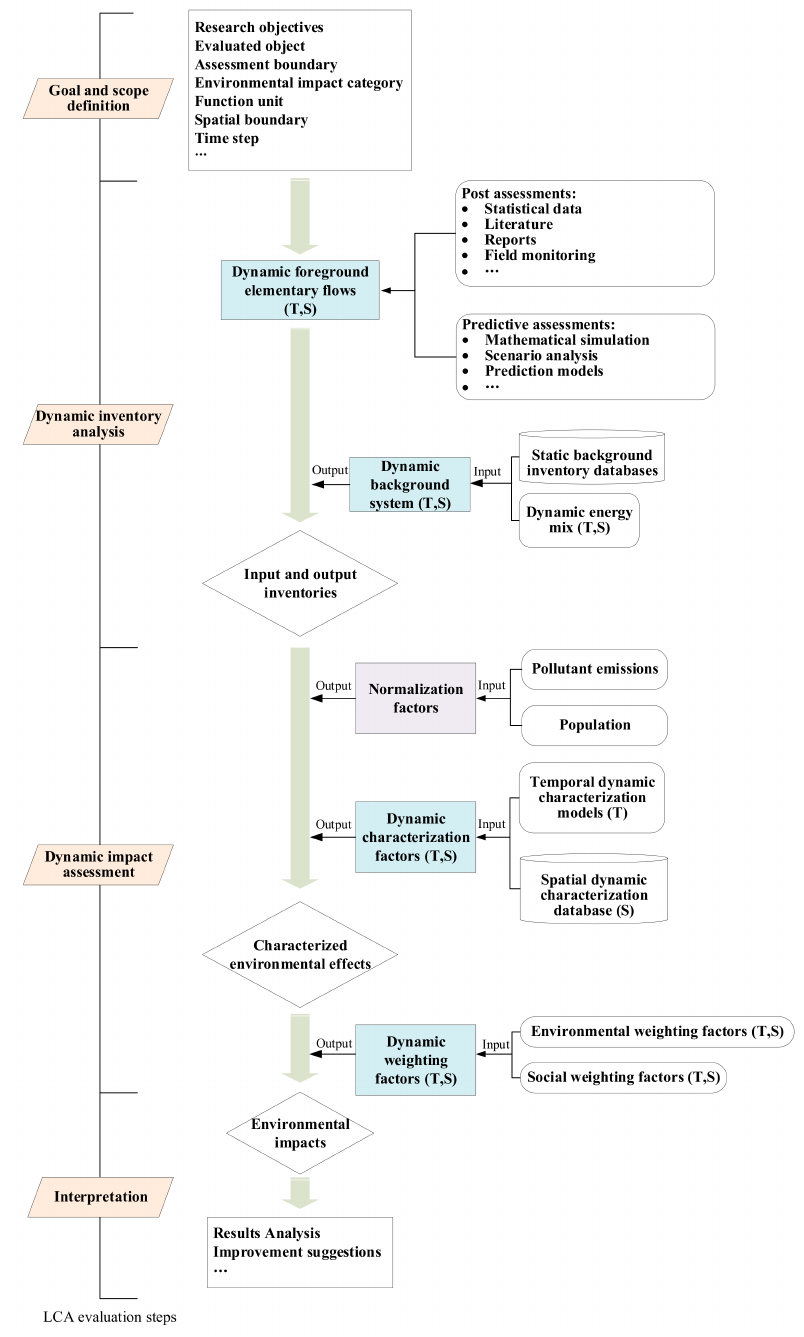
Figure 1. The spatiotemporal DLCA